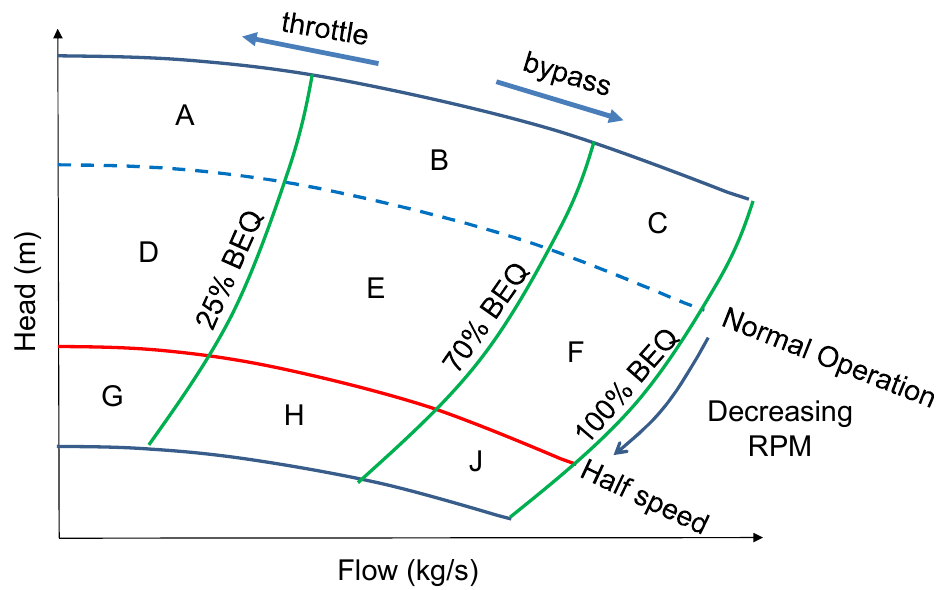
Figure 1. Example schematic for the pump curve associated with an Advanced Gas Cooled Reactor (AGR) boiler feedpump, marked up to show regions of preferred and non-preferred operation. Regions F and J denote preferred regions that are dependent on operating speed. Regions D and G are to be avoided.